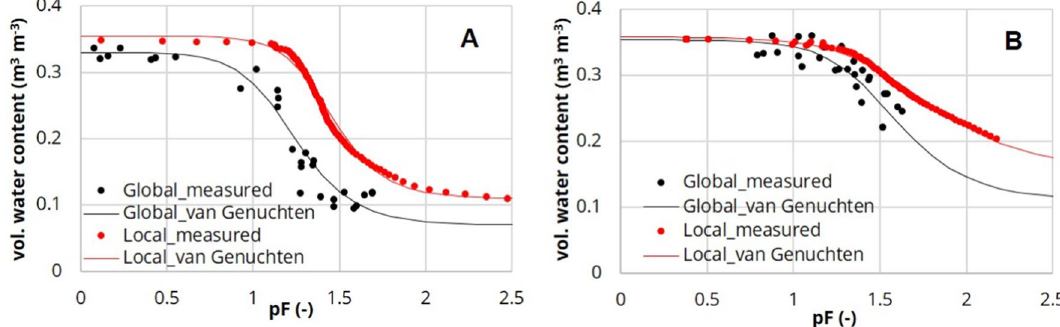
Fig. 2 Local and global determined soil water retention curves—measured (dots) and by means of the van Genuchten model (lines) for soil1 ( A ) and soil 2 ( B )